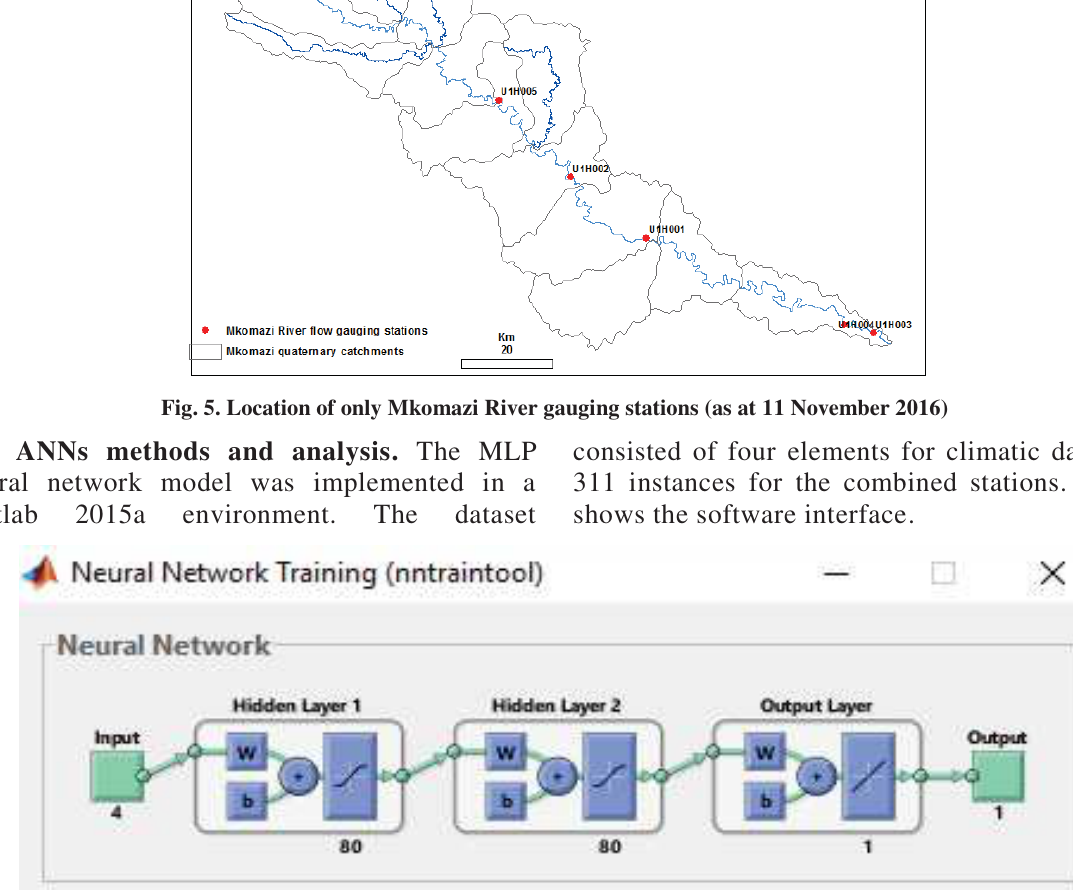
Fig. 6. Neural network training in a Matlab